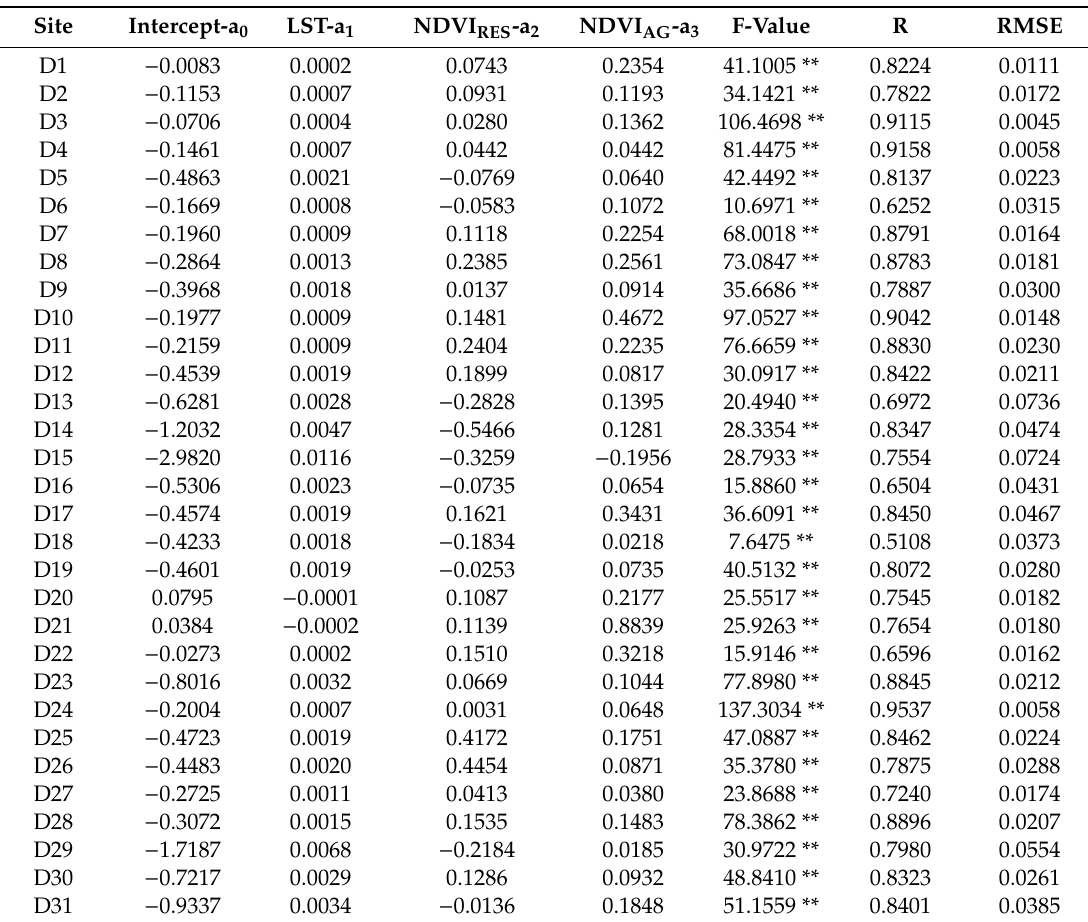
Table A2. Layer soil moisture estimation model (20–30